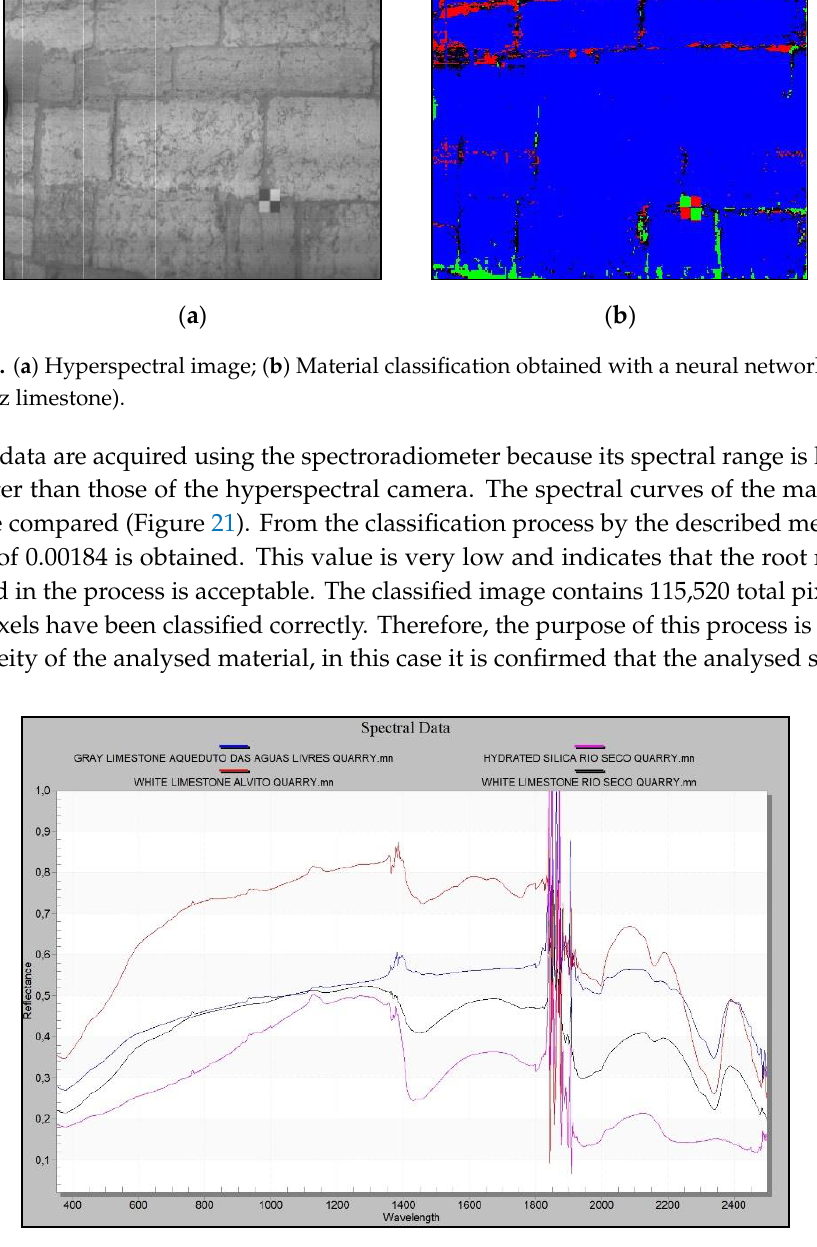
Figure 21. Reflectance spectral signatures of materials in the quarries. Gray limestone from Aqueduto das Aguas Livres Quarry (Blue) and hydrated silica Rio Seco Quarry (Purple) differing significantly from the white limestones in Alvito Quarry (Red) and Rio Seco Quarry (Black).